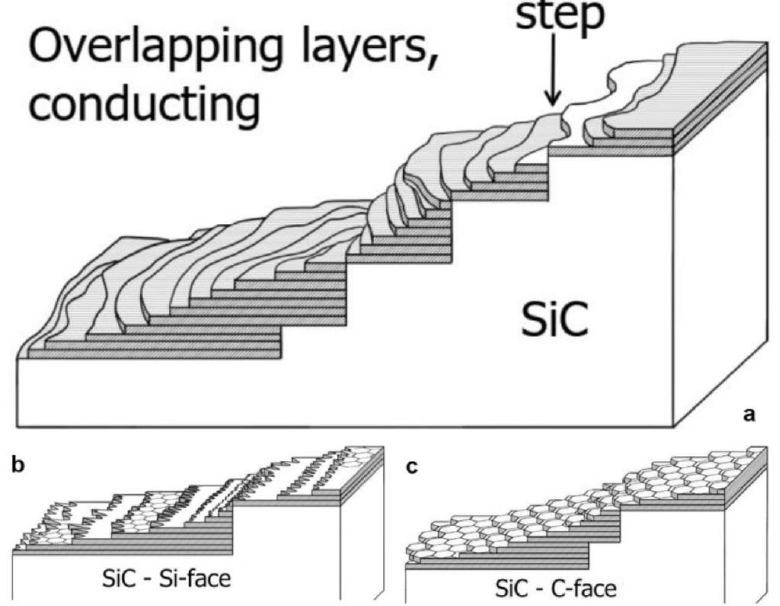
Figure 6. Schematic representation of the stock work of graphene layers on a SiC substrate. ( a ): An over-representation of atomic steps on the depicted substrate to be able to demonstrate the structure better. The substrate was an on-axis, industrially cut SiC wafer. Thus, some atomic steps could not be avoided, even though technically the substrate was cut in crystallographic plane orientation. Overlapping graphene layers allow for step-normal conductivity, while steps that are not completely overgrown account for a limited conductivity; ( b , c ): schematic figure, showing the difference in growth geometry of graphene on the two polar faces of